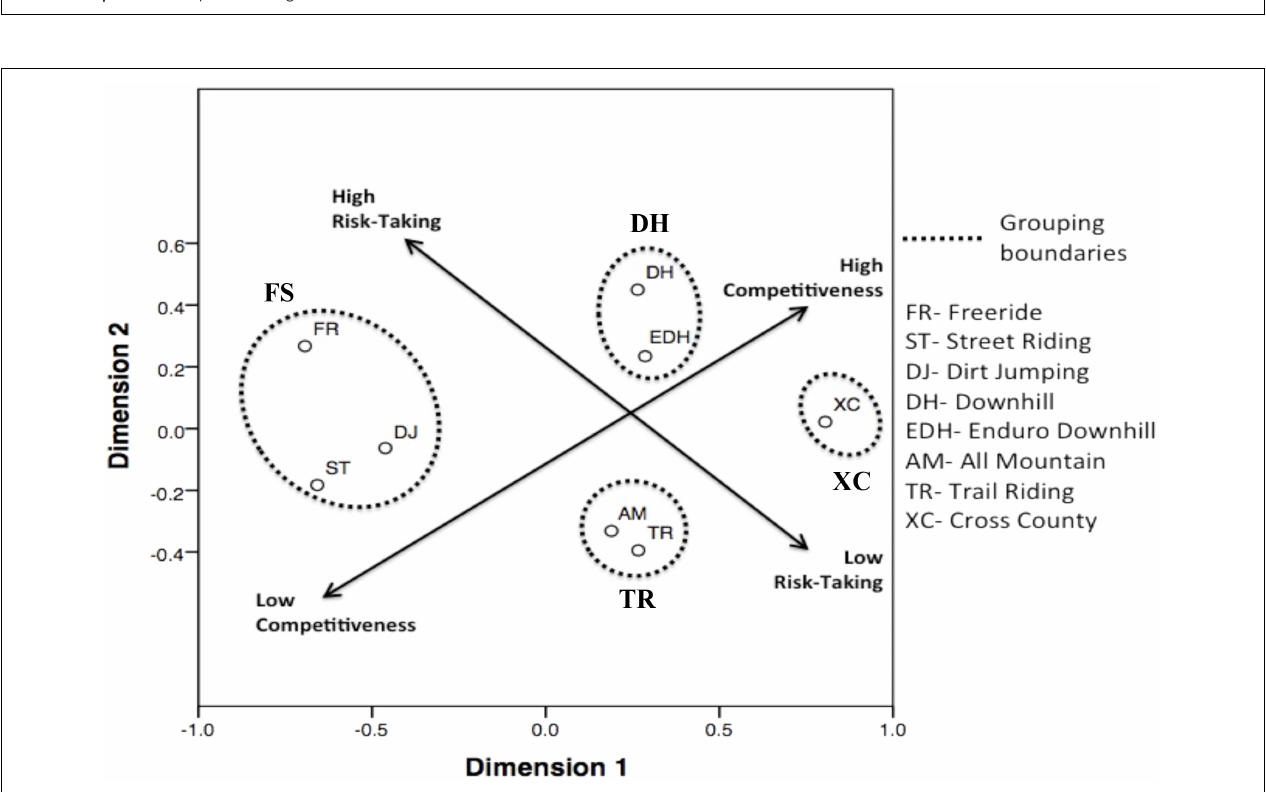
FIGURE 2 | MDS scree plot showing two-dimensional solution.